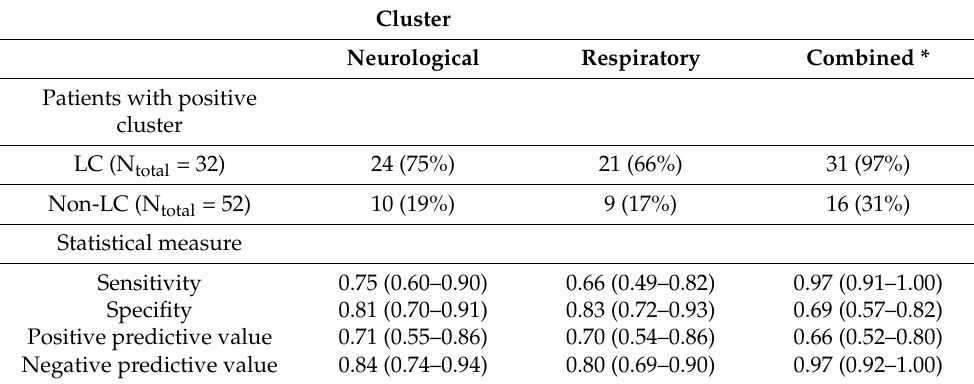
Table 4. Sensitivity, specificity, and predictive values to identify patients with LC versus alternative diseases from clinical symptom clusters in suspected pediatric Long COVID.